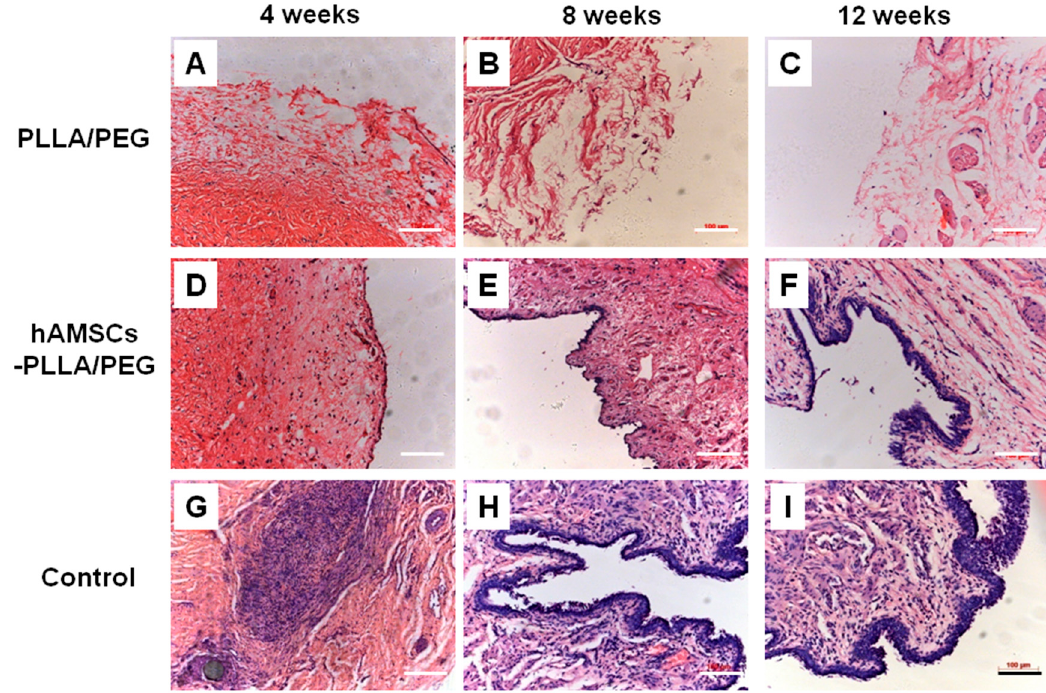
Figure 6. Hematoxylin–eosin (H&E) staining of the urethral tissues at 4, 8, and 12 weeks